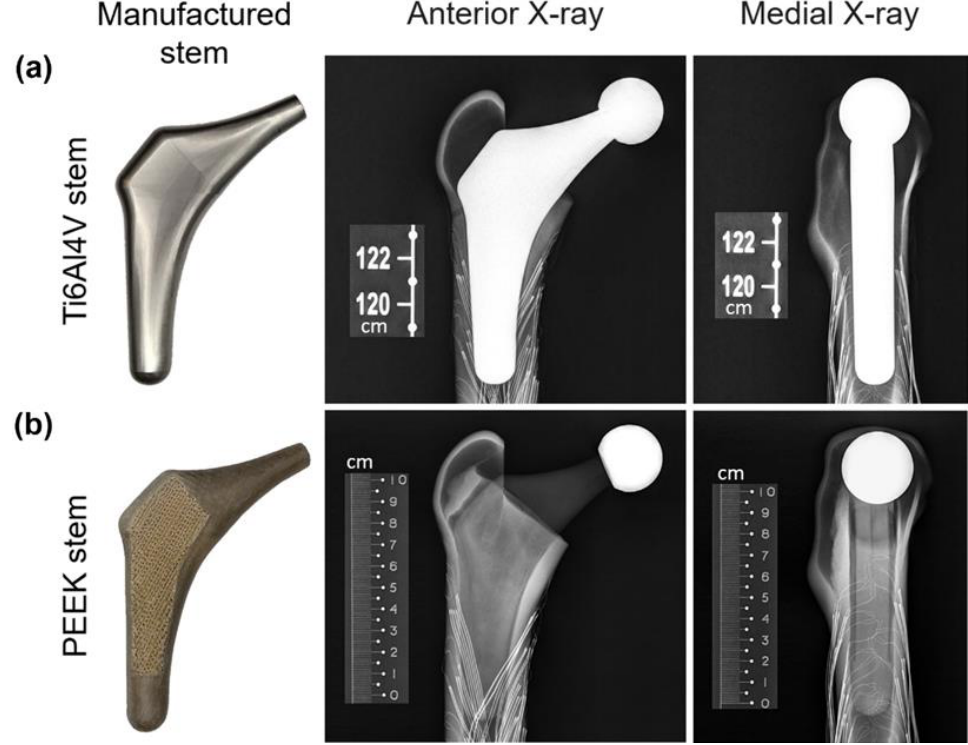
Figure 4. X-ray images of the Ti6Al4V (a) and PEEK (b) stems implanted in the Sawbone.